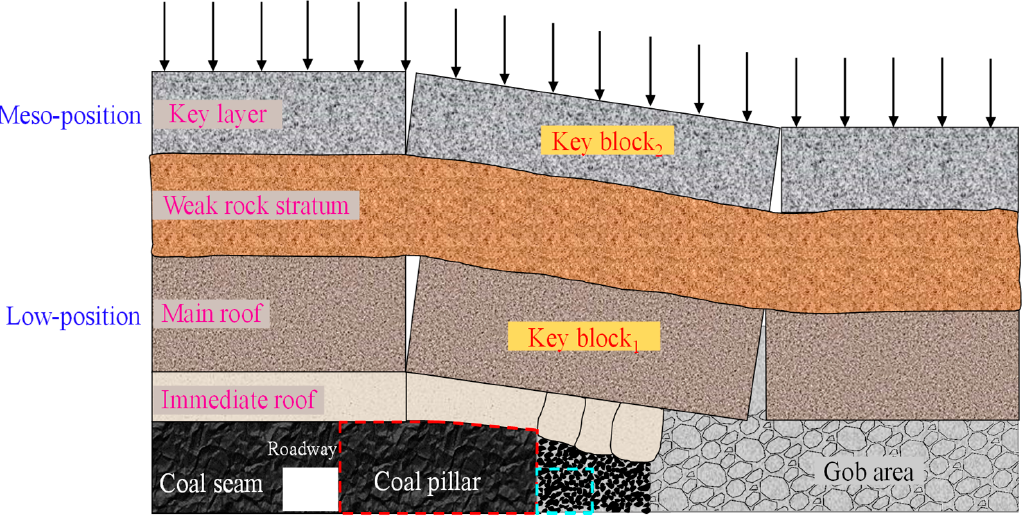
Figure 6. Compound triangle block structure model [47].